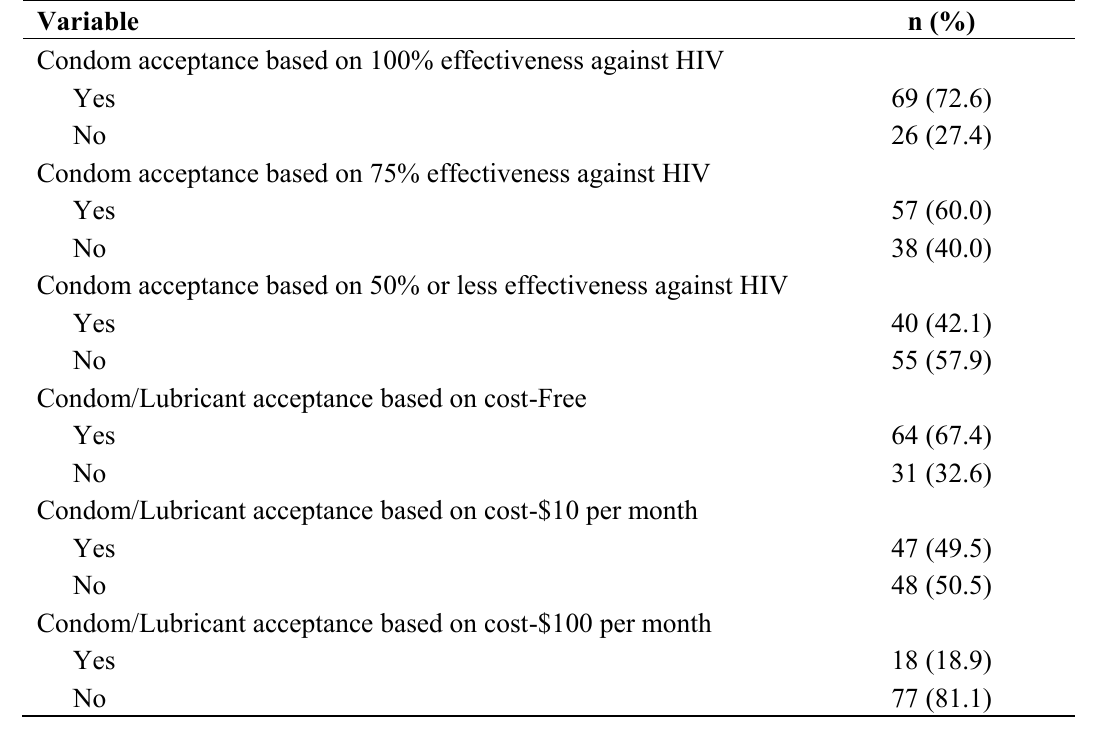
Table 4. Acceptance of condoms as a safe sex measure ( N =